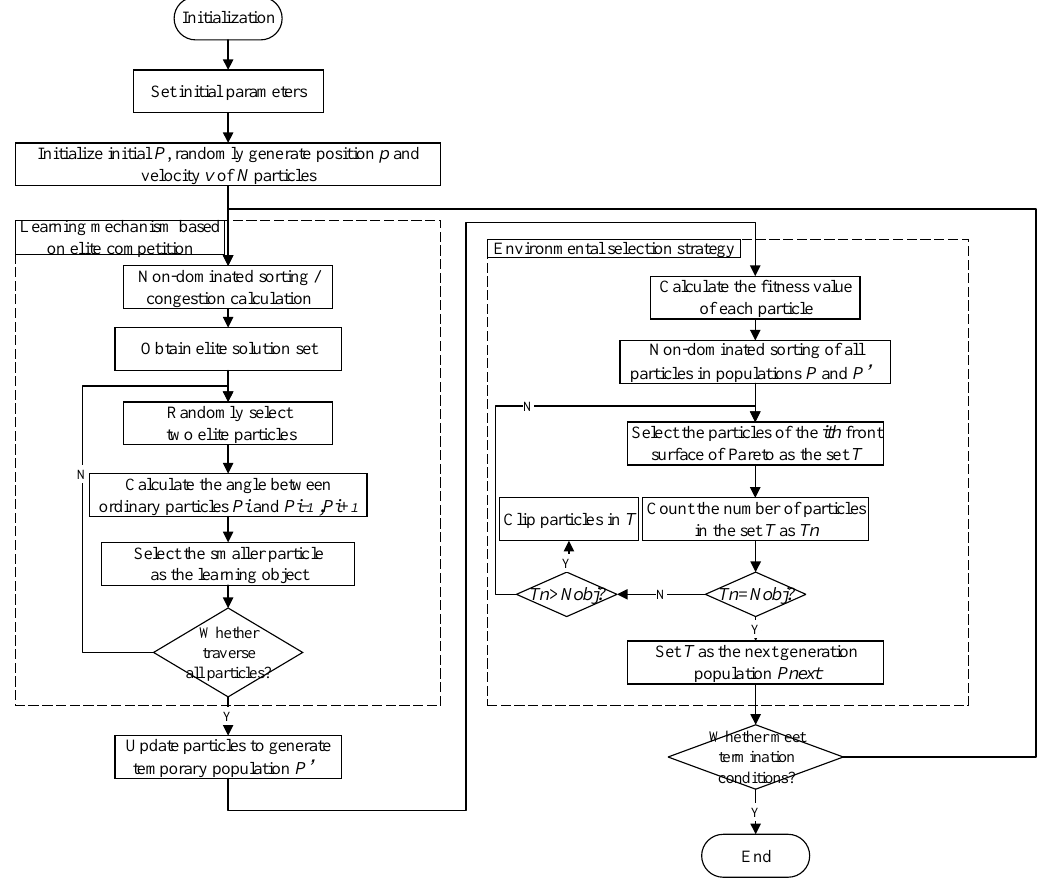
Figure 8. Flow chart of the THEC-APC multi-performance optimization based on the competitive- mechanism-based multi-objective particle swarm optimizer (CMOPSO) algorithm. competitive-mechanism-based multi-objective particle swarm optimizer (CMOPSO)